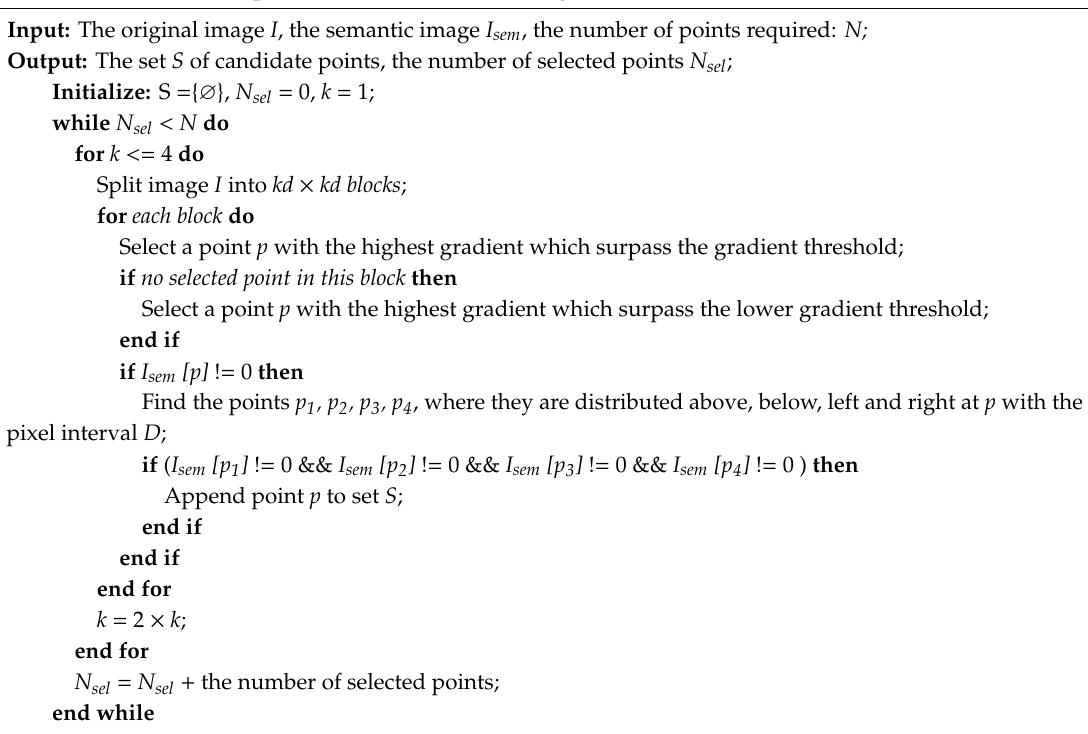
Algorithm 1: Candidate points extraction based on image semantic